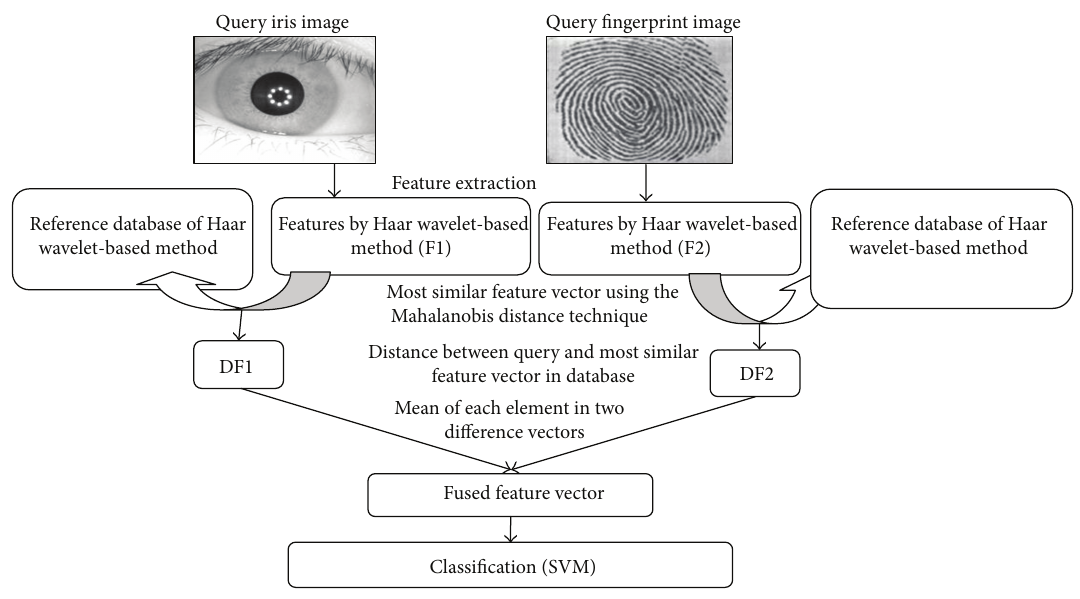
Figure 4: Architecture for feature fusion.